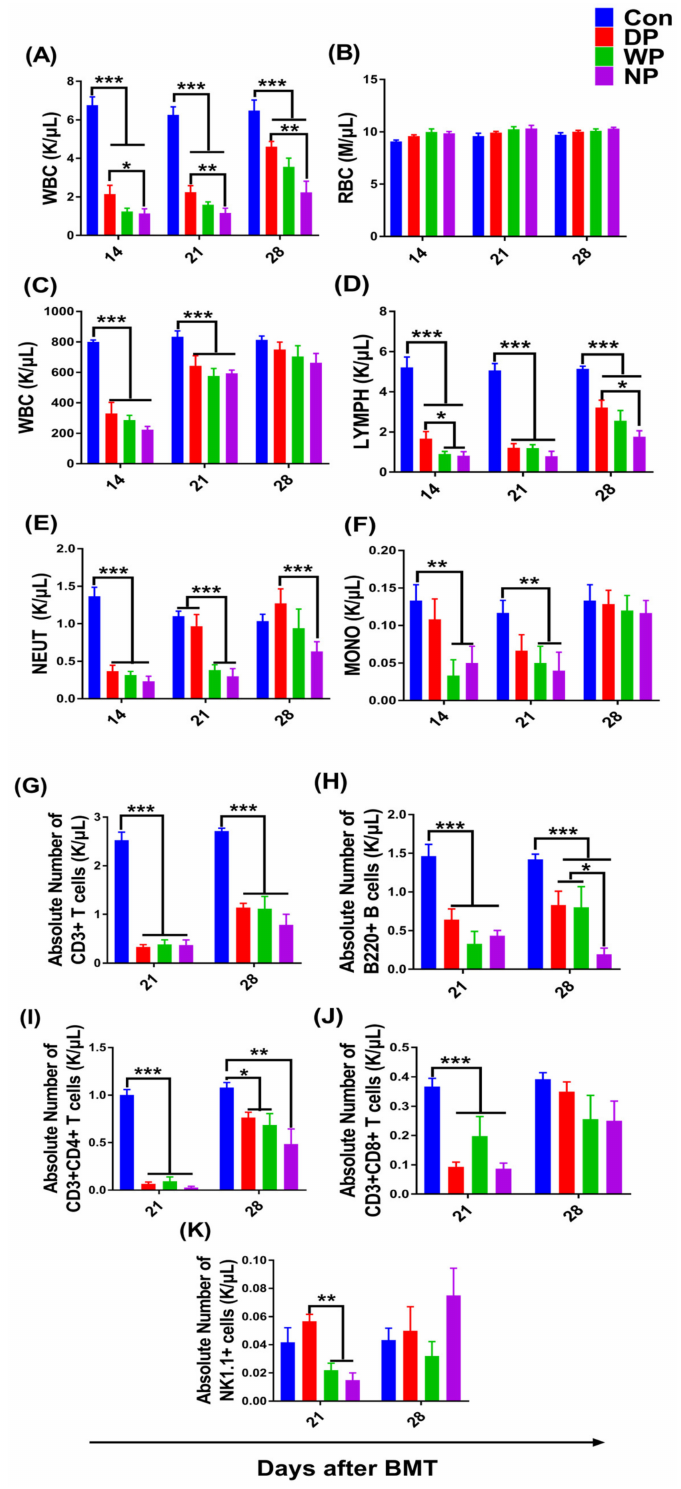
Figure 2. Peripheral blood cell count and lymphoid subsets analysis versus time. Peripheral blood was collected from orbital sinus on day 14, 21, and 28 after BMT for the measurement of cell count including WBC, RBC, PLT, LYMPH, NEUT, and MONO ( A – F ); the absolute numbers of CD3 + , B220 + , CD3 + CD4 + , CD3 + CD8 + , and NK1.1 were calculated using flow cytometry results combined with the lymphocyte count in peripheral blood on day 21 and 28 ( G – K ). Data are presented as mean ± SEM ( n = 6). Results are representative of at least two independent experiments. *** p < 0.001, ** p < 0.01, * p <